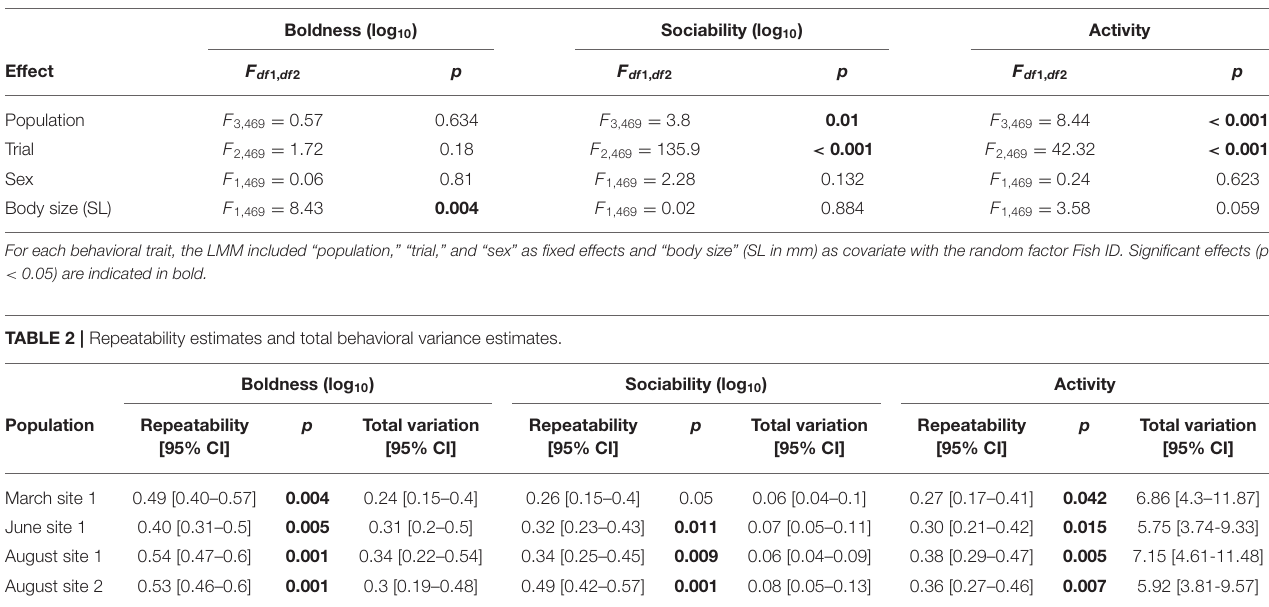
TABLE 1 | Results from linear mixed models.